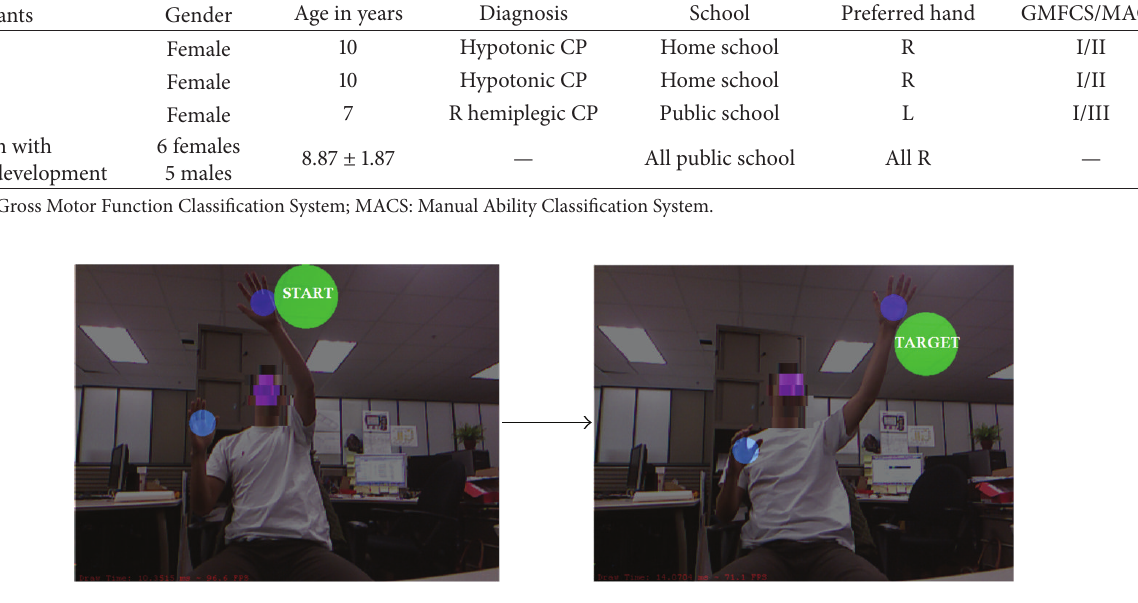
Figure 2: Super Pop VR game with “Super Bubble.” The green bubble on the screen is a “Super Bubble.” The player was moving his left hand from Super Bubble 1 to Super Bubble 2. The sizes of “Super Bubble” can be